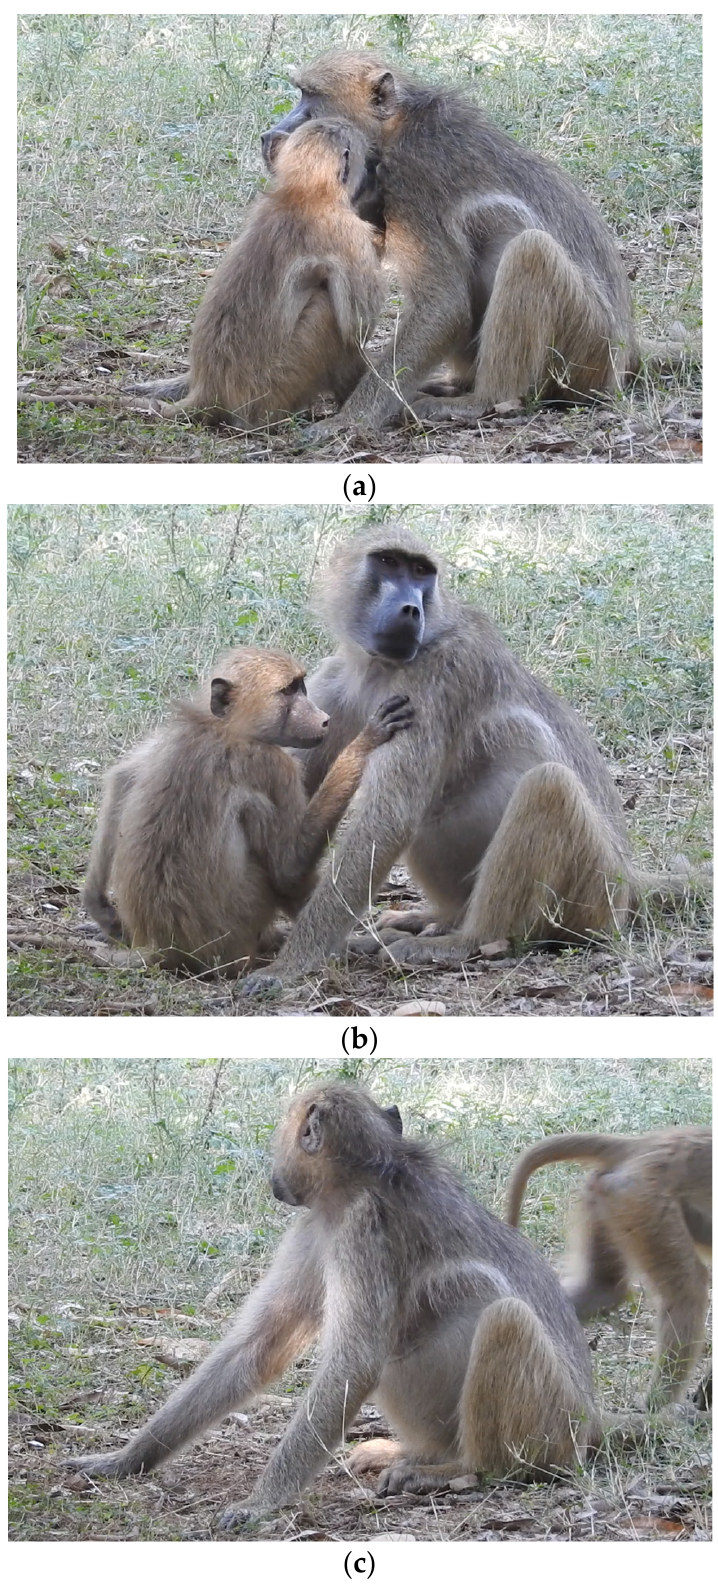
Figure 1. ( a ): An activity is occurring between a dyad. ( b ): The preparting window two minutes before departure; individuals often stop the activity and may perform “leave-taking” behaviours. ( c ): An individual departs, moving away from the other individual in the dyad by >1 m.